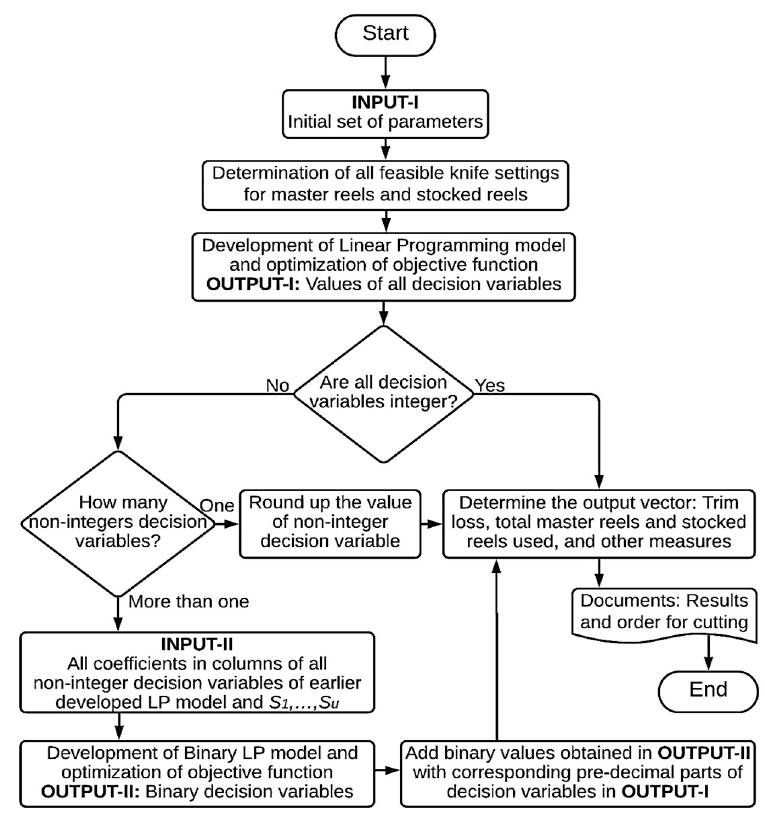
Figure 2. Optimal cutting algorithm.